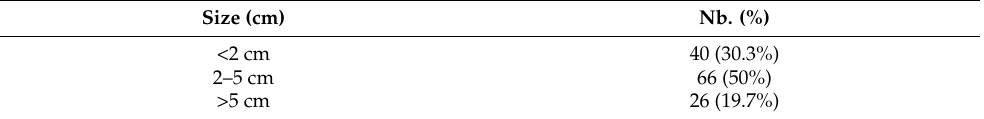
Table 3. Tumor size at diagnosis ( n =